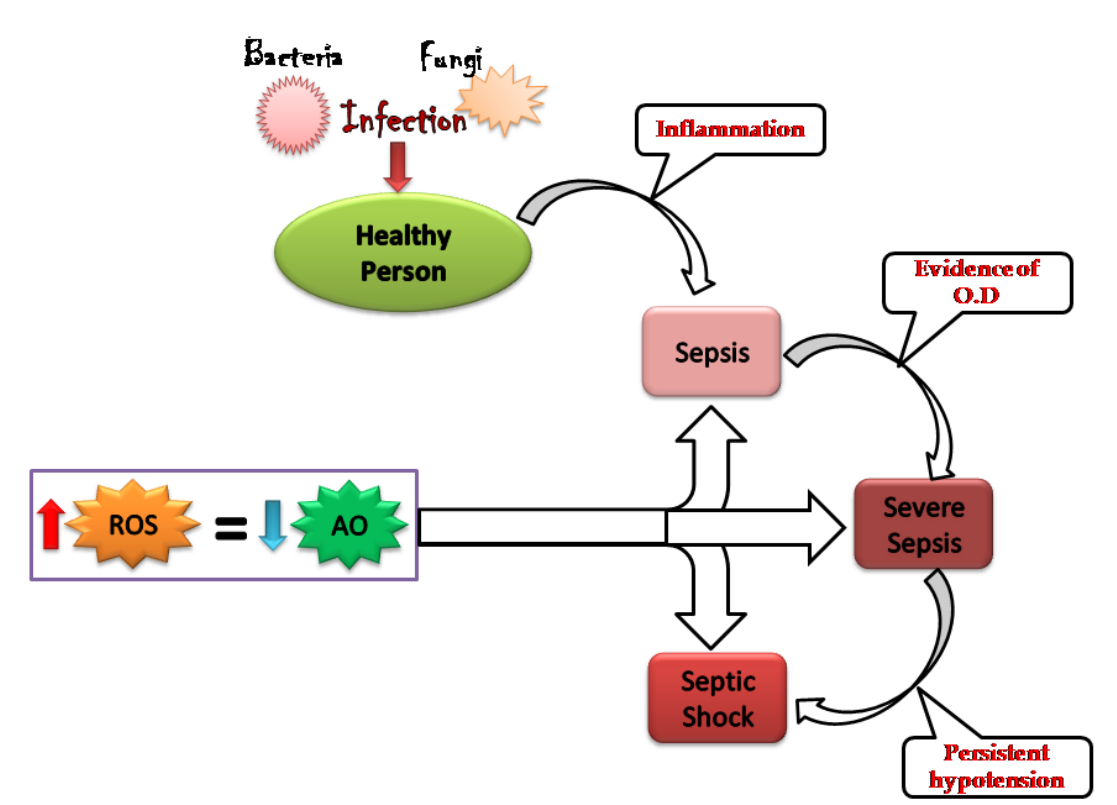
Figure 1. Schematic representation of the pathogenesis of sepsis with stages of severity with a view on oxidant and antioxidant levels.